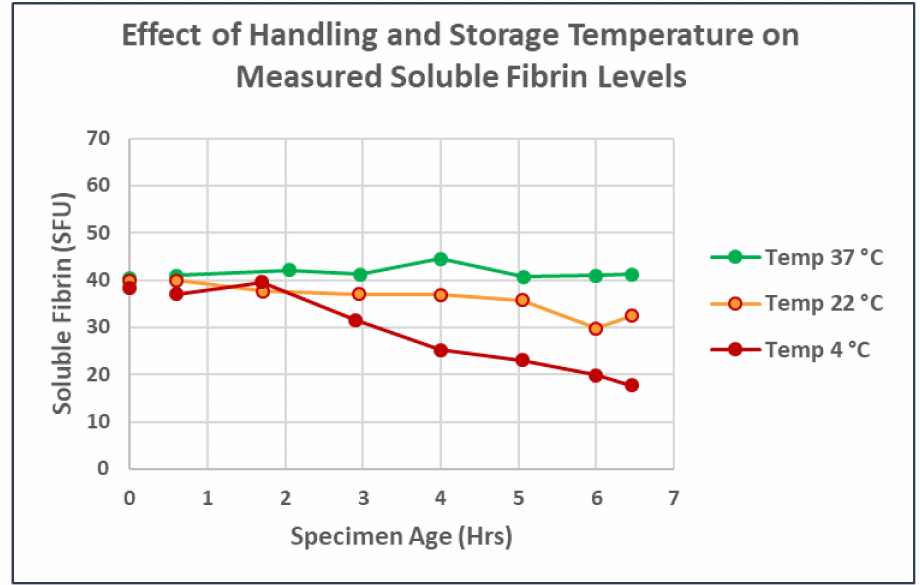
Figure 1. Blood was drawn from a normal donor and treated with thrombin, as described in Section 2.2.2, to achieve an SF of approximately 40 SFU. The treated blood was then each split into three syringes for storage at the three target temperatures (37 ◦ C, 22 ◦ C and 4 ◦ C). Each syringe was initially tested (time 0) then all were placed at their respective temperature storage locations. At periodic intervals, each syringe was removed from storage, mixed, and a small portion removed and rewarmed to 37 ◦ C for SF testing. Syringes were immediately returned to their designated temperatures. Samples with elevated SF that were maintained at 37 ◦ C remained stable for over 6 h. However, at both room and refrigeration temperatures, measured SF levels dropped over time. In our experience, samples with SF levels greater than 50–60 SFU show precipitous drops in measured SF when cooled to 4 ◦ C, with measured values plummeting into even the normal range. In contrast, SF values in the normal range show minimal change under the same